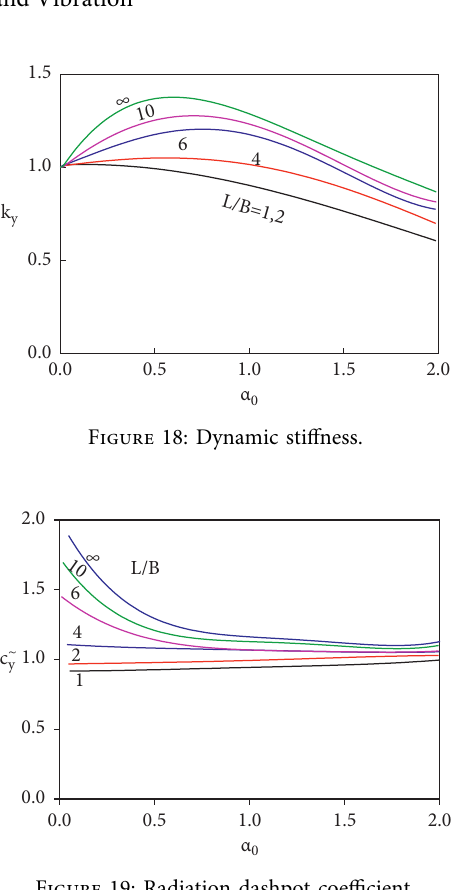
Figure 19: Radiation dashpot